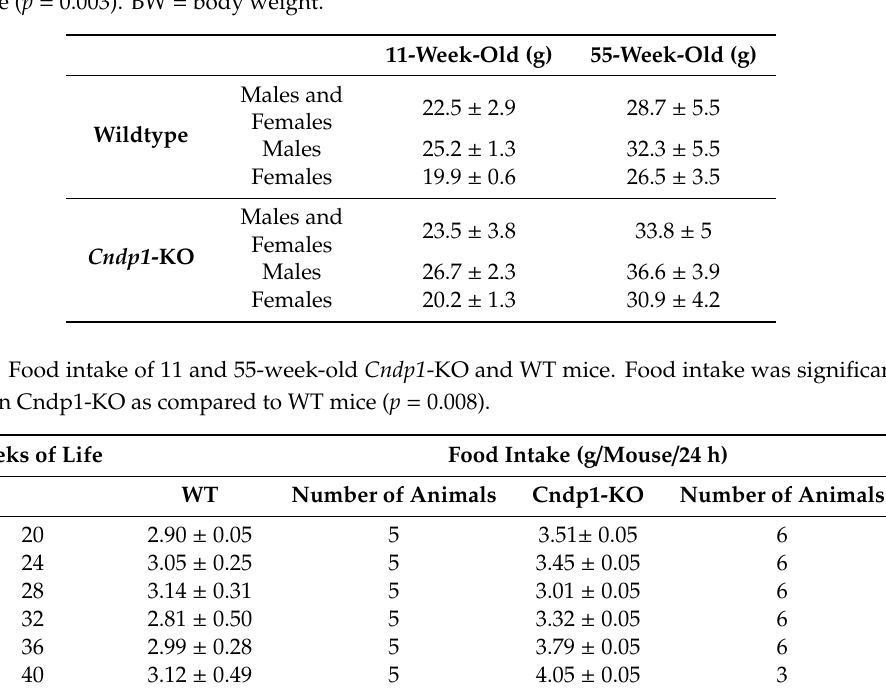
Table 4. Body weights of 11- and 55-week-old Cndp1 -KO ( n = 16 and n = 48) and WT mice ( n = 18 and n = 18). Until the age of 55 weeks body weight increased by 44% in Cndp1 -KO mice, but only by 27% in WT mice ( p = 0.003). BW = body weight.